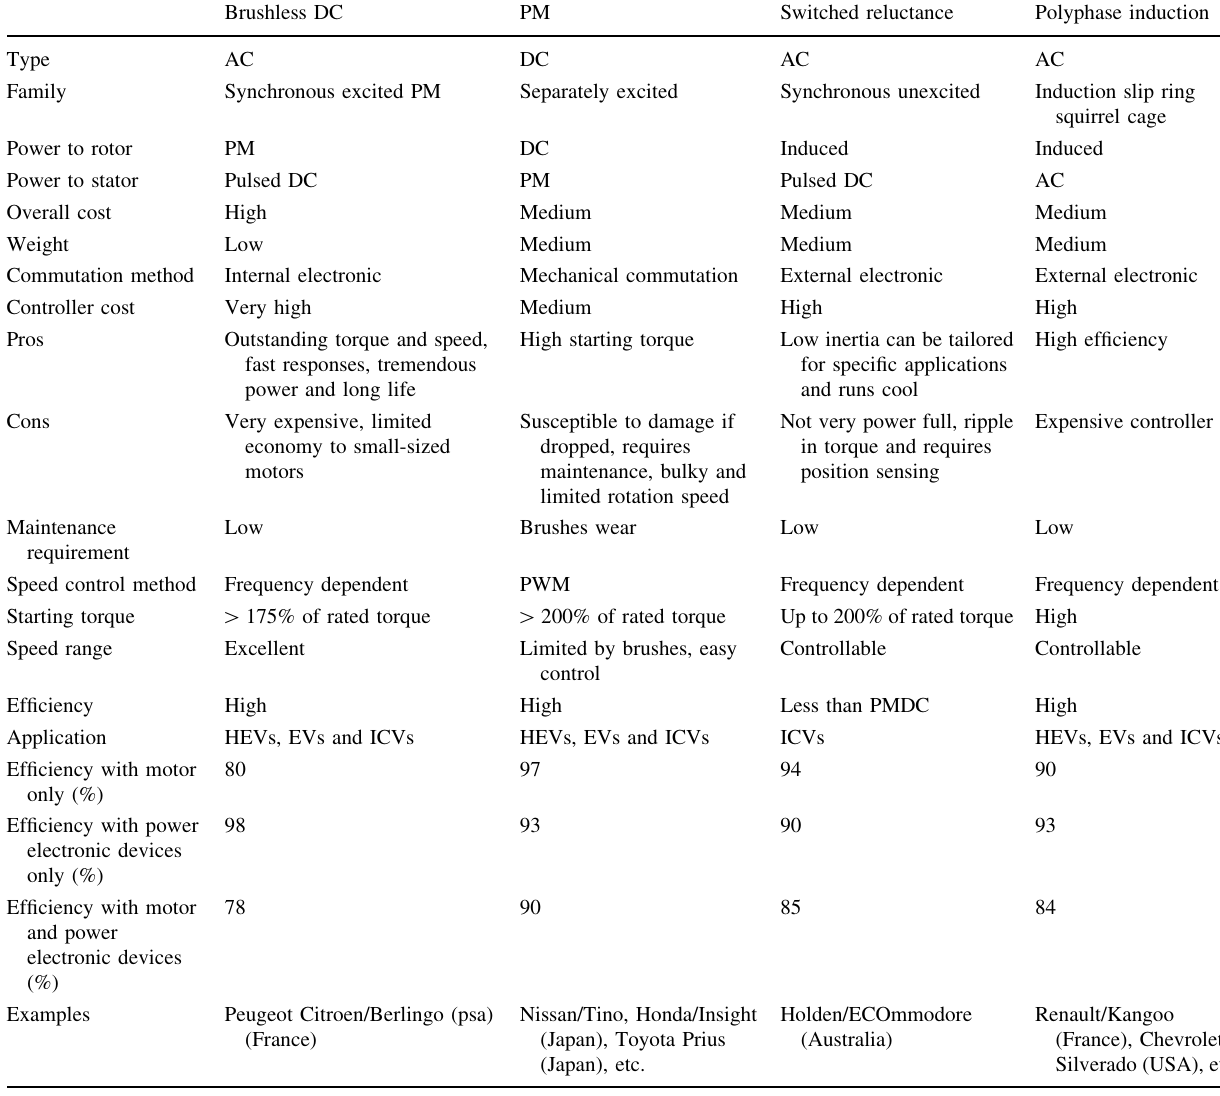
Table 6 Comparison of various motors used in HEV [151]